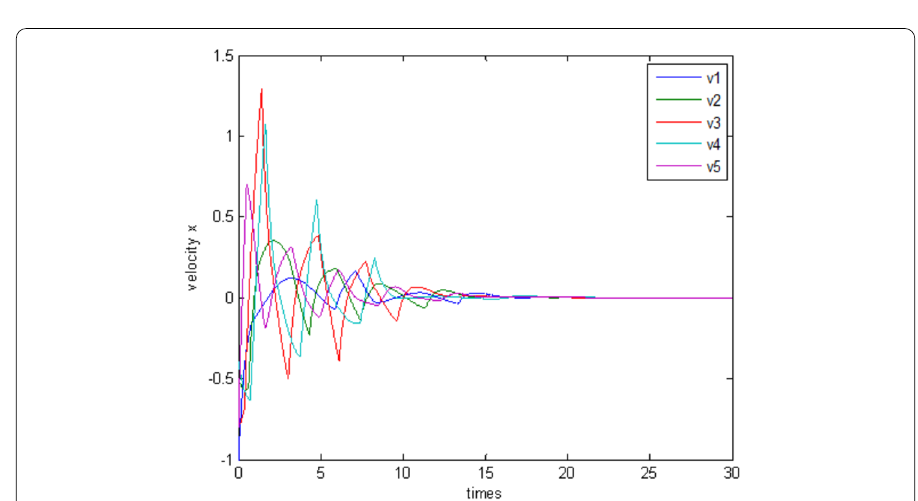
Figure 3 Velocity trajectories of all the agents